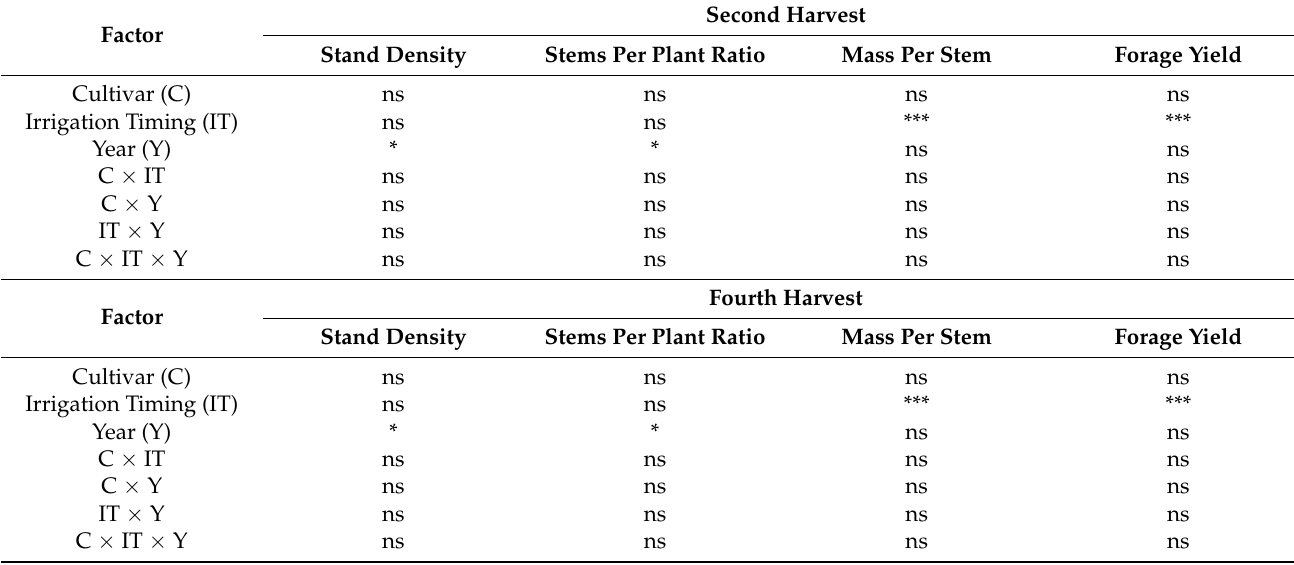
Table 7. The effects of the experimental factors on the stand density, number of shoots per plant, mass per shoot, and forage yield values recorded, in the second and the fourth harvest, across the two experimental years. The p -values were derived from an analysis of